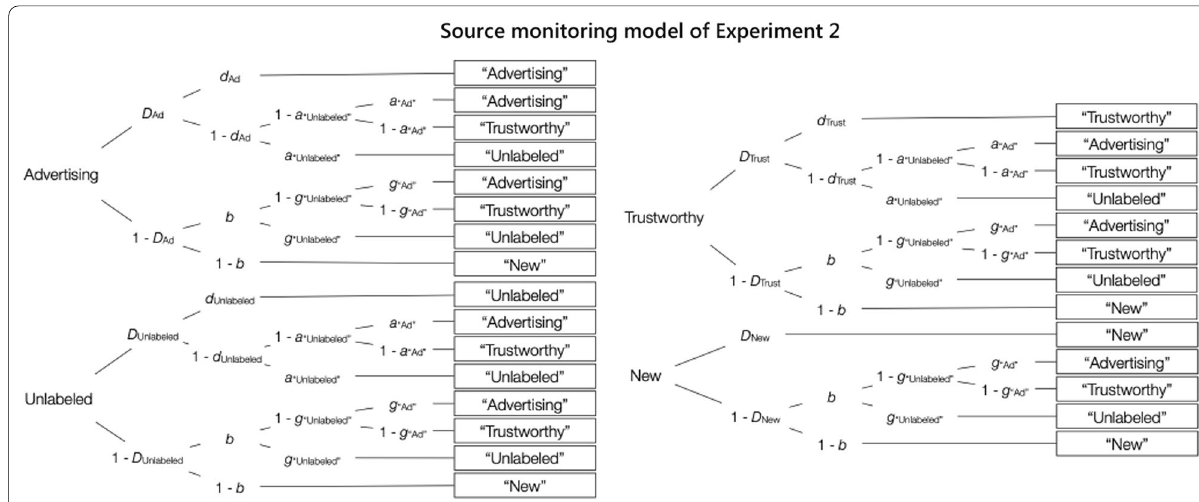
Fig. 5 Source-monitoring model of Experiment 2. Note : The model was adapted to Experiment 2 from the three-source source-monitoring model of Keefe et al. (2002). Each tree represents the cognitive processes in response to the advertising, unlabeled, trustworthy, and new statements that were presented in the source-monitoring test. The rectangles on the right represent the participants’ responses. Letters along the branches represent the latent cognitive processes which lead to these responses with certain probabilities ( D ∙